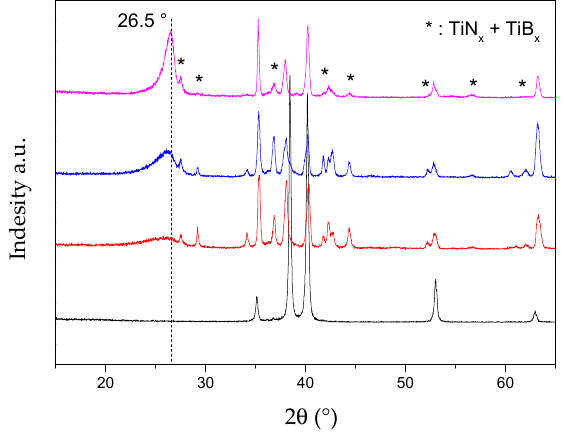
Figure 11. XRD patterns recorded on samples TiBN0 ( black ), TiBN1 ( red ), TiBN3 ( blue ) and TiBN5 (magenta).